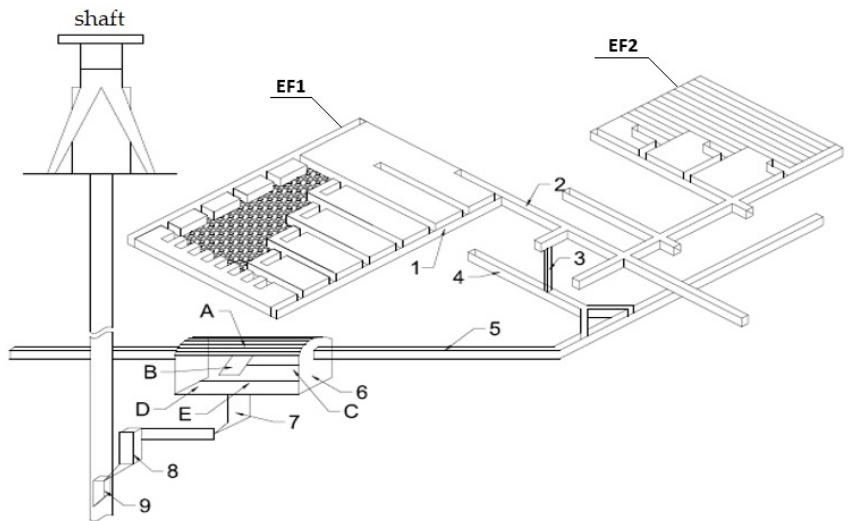
Figure 9. The way of transporting the excavated material from the exploitation field to the surface: EF1—exploitation field no 1; EF2—exploitation field no 2; 1—haulage room; 2—transportation drift; 3—discharge (chute) small shaft; 4—field rock drift; 5—main rock drift; 6—dump’s room; 7—storage reservoir; 8—measure reservoir; 9—skip hoist; A—passable dump; B—inclined plane; C—steel membered conveyor; D—jaw crusher; E—belt conveyors.